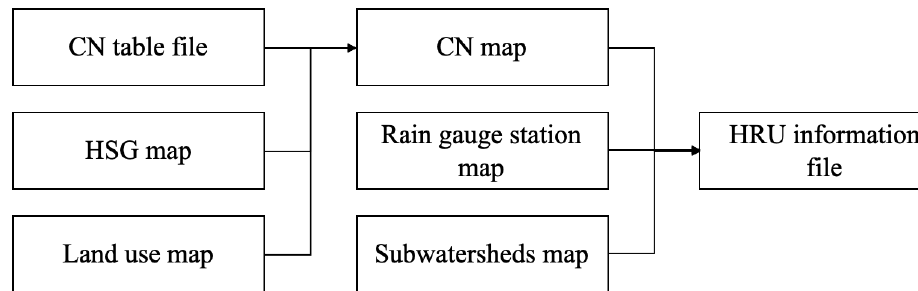
Figure 1. Schematic illustration of HRU information file.